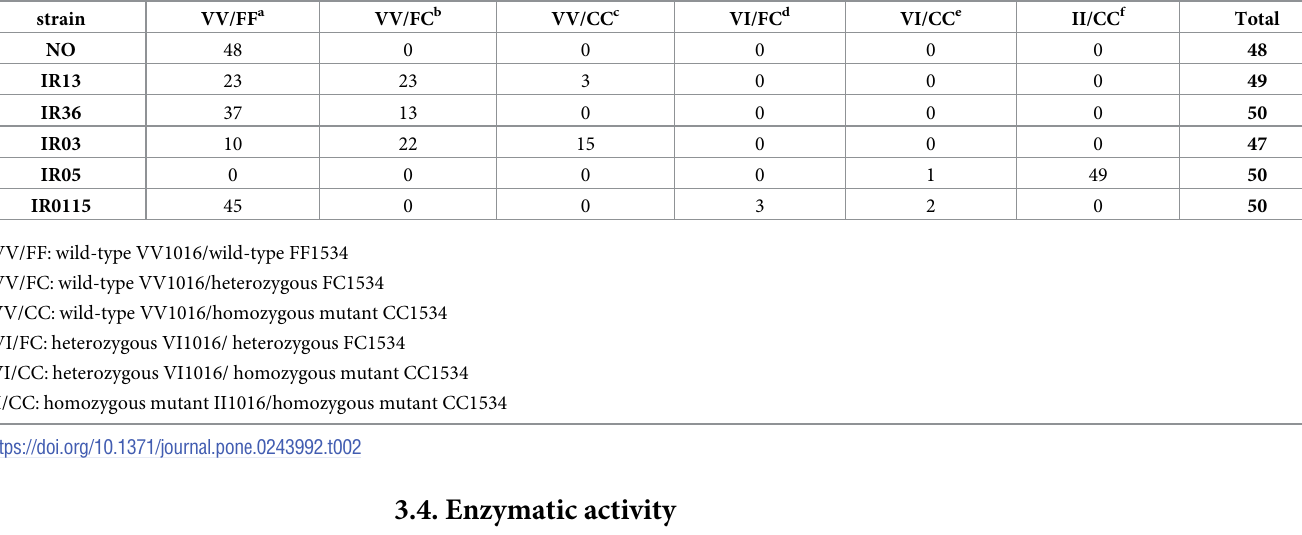
Table 2. Coexistence of genotypes of V1016I and F1534C mutations in six strains of Aedes